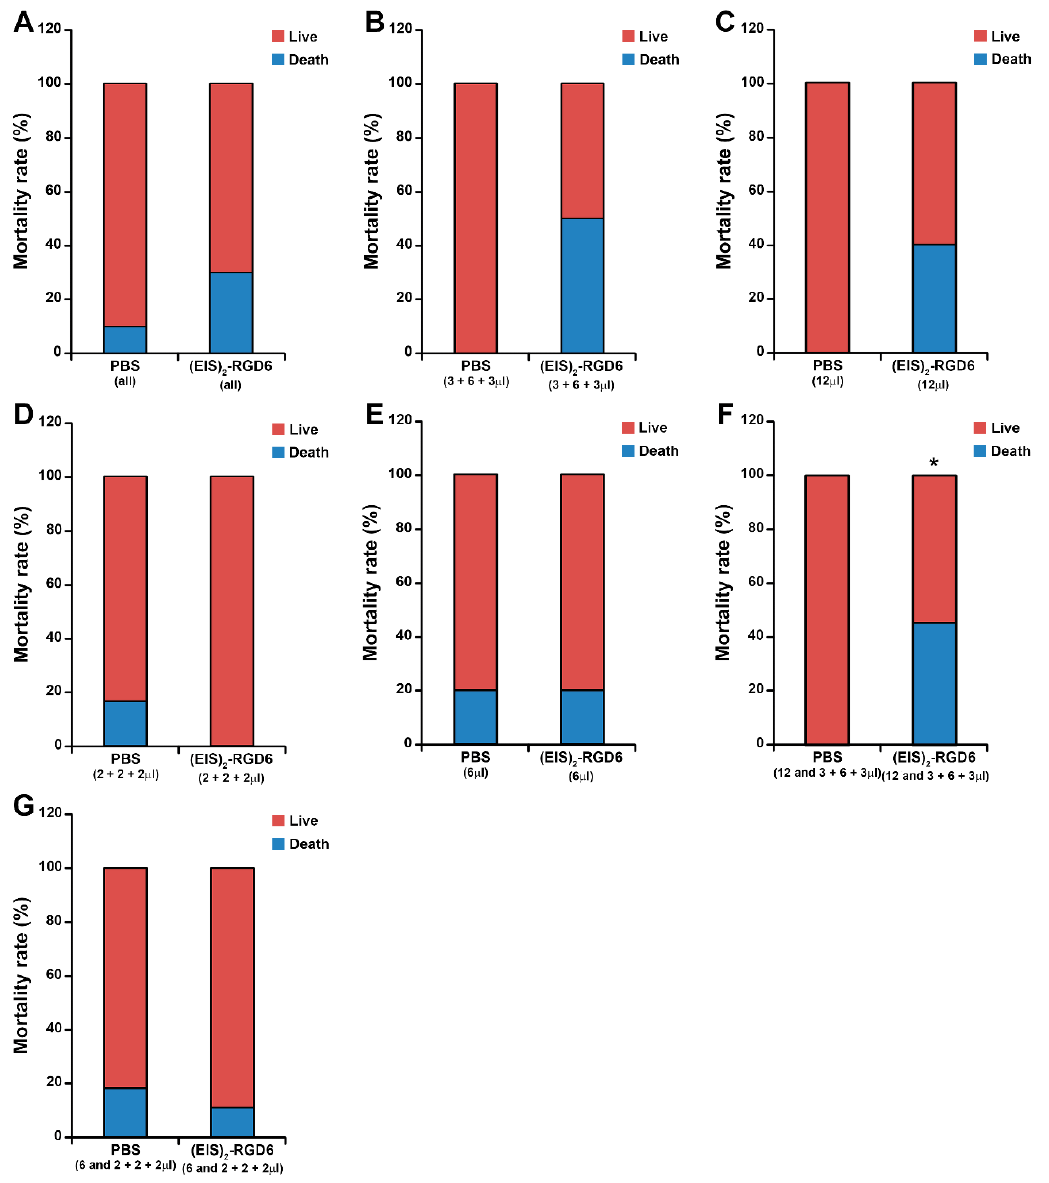
Figure 8. Determination of the injection system: Mortality rate. Graphs show data obtained from the evaluation of mortality rate in animals from the experimental set performed to determine the best (EIS) 2 -RGD6 injection system [experiment (EIS) 2 -RGD6 I]. The following comparisons were performed: ( A ) All PBS-injected animals (PBS 6 µ L, PBS 2 + 2 + 2 µ L, PBS 3 + 6 + 3 µ L, and